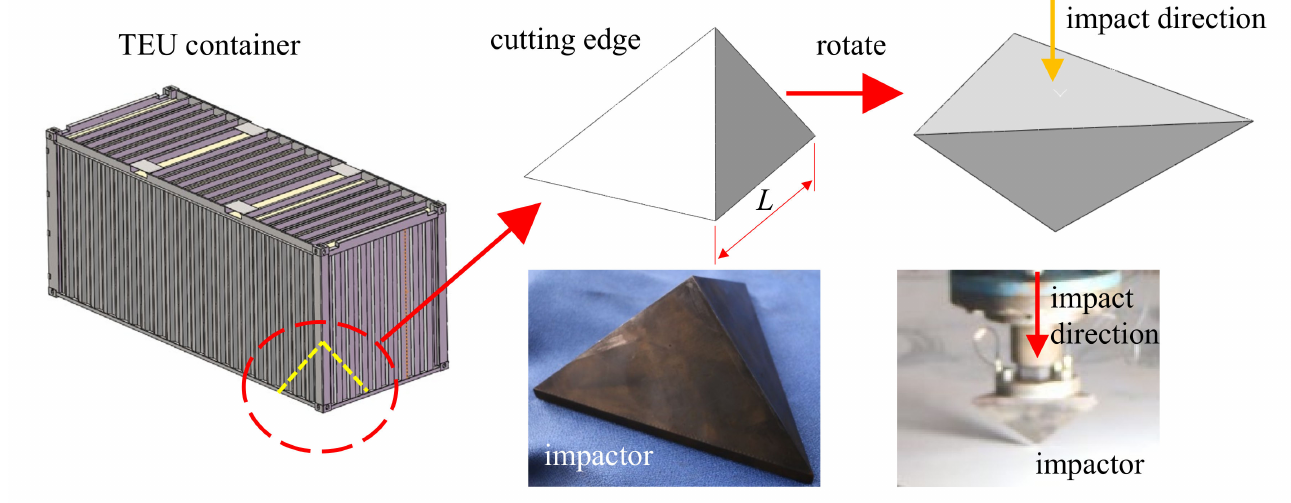
Figure 3. TEU (Twenty feet Equivalent Unit) container and the triangular pyramidic